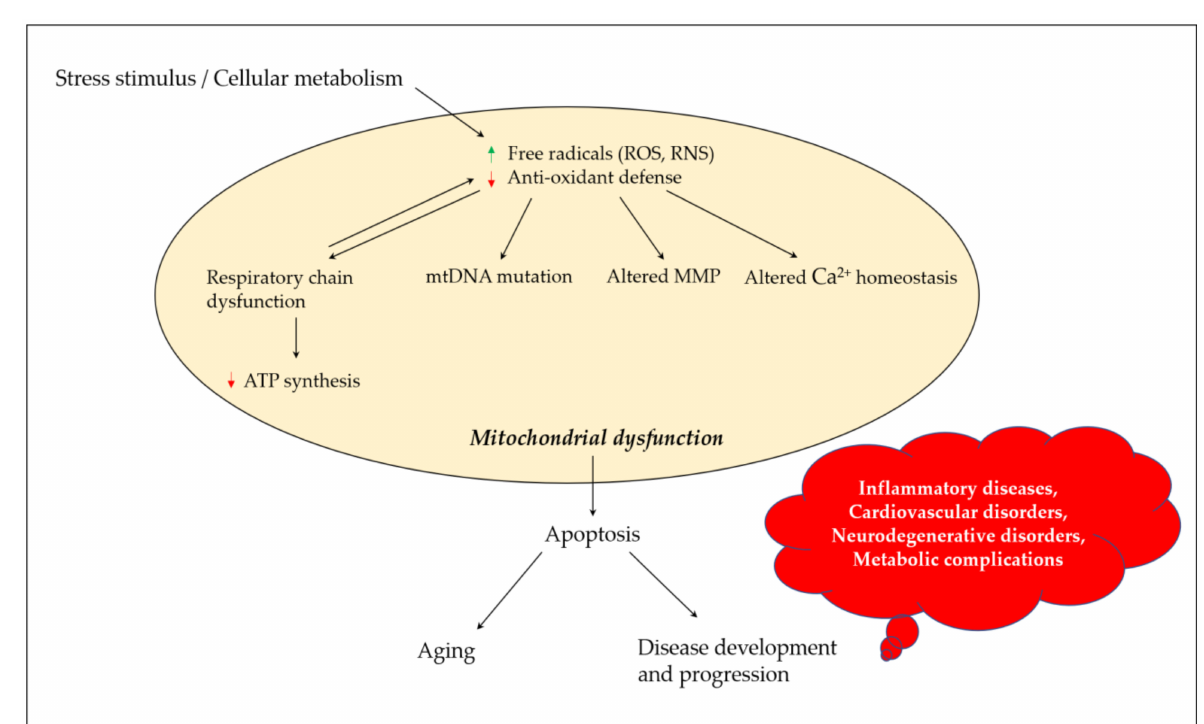
Figure 1. Mitochondrial dysfunction and its contribution towards aging and disease development and progression. Stress stimulus and irregular cellular metabolism may lead to the increased production of ROS and RNS, and decreased antioxidant defense parameters, which eventually result in mitochondrial dysfunction due to a defective mitochondrial respiratory chain, mutation in mtDNA, altered MMP and influenced Ca 2+ homeostasis. These events could promote apoptosis, paving the road for aging and disease development and progression. ROS, reactive oxygen species; RNS, reactive nitrogen species; mtDNA, mitochondrial DNA; MMP, mitochondrial membrane potential; ATP, adenosine